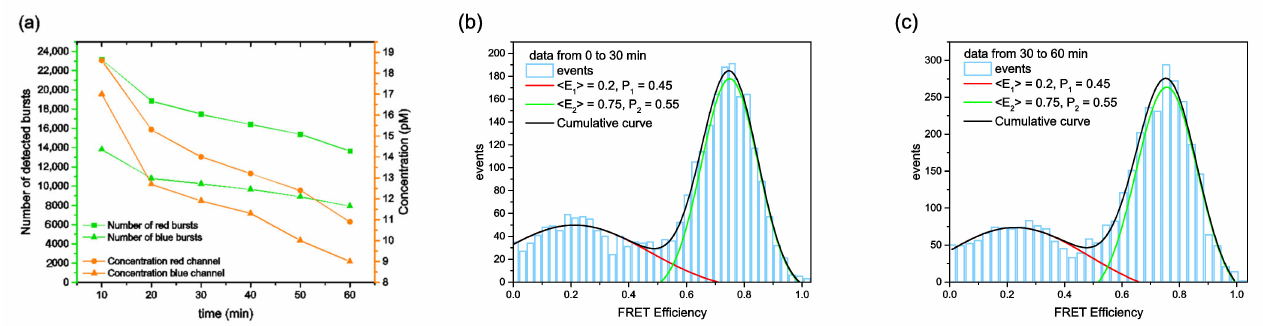
Figure 3. Results as obtained from smFRET measurements with PGK at 0.65 M GuHCl denaturant concentration. ( a ) The number of detected bursts and the related molar protein concentration was given during the total measuring time (60 min) for time intervals of 10 min. ( b , c ) The corresponding smFRET transfer efficiency histograms are shown for the first 30 min ( b ) and for the last 30 min ( c ). In both histograms, the unfolded state population (at <E 1 > ≈ 0.2) and the folded state population (at <E 2 > ≈ 0.75) were within the limits of error of the same statistical weights P 1 ≈ 0.45 and P 2 ≈ 0.55, respectively (area under the respective fitted Gaussian